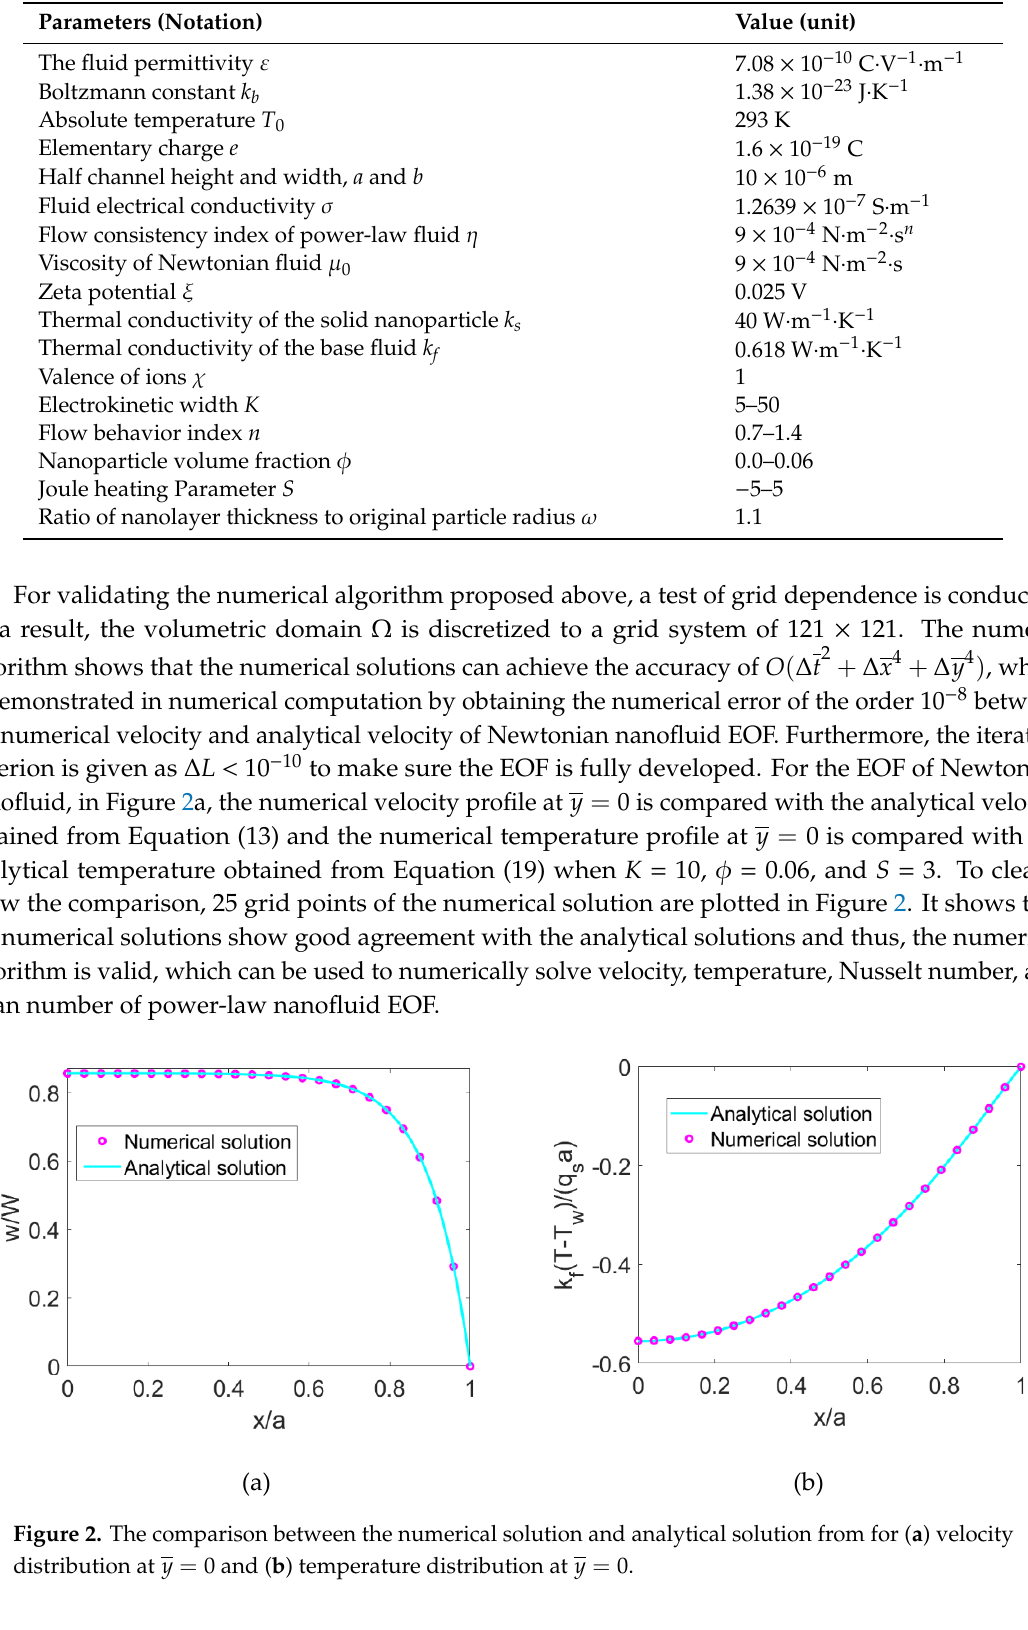
Table 1. Typical values of the parameters.